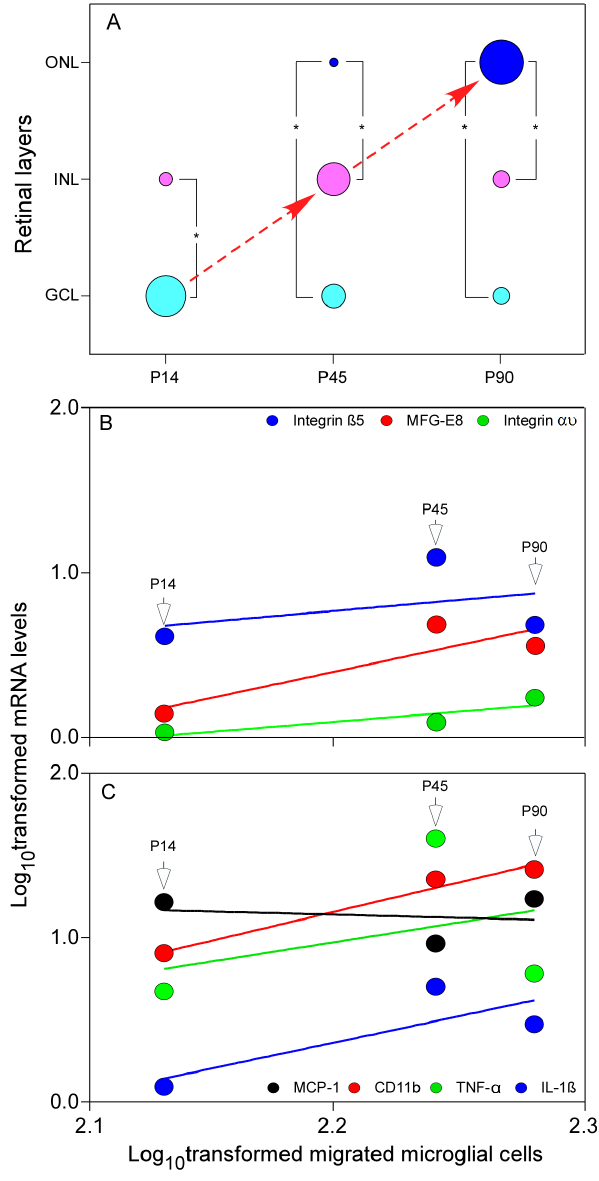
Figure 5. The distribution of migratory microglial cells and the association between mRNA levels and the number of migrated microglial cells during retinal degeneration in RCS rats. (A) The distribution of microglial cells in the retina of RCS rats from GCL to ONL during retinal degeneration from P14 to P90. (B) mRNA levels of MFG-E8 and integrin au showed more significant linear regression with the migration of microglial cells than the integrin b 5. (C) mRNA level of CD11b was significantly associated with the migration of microglial cells and IL-1 b and TNF- a showed a modestly linear regression, but the association between mRNA levels of MCP-1 and microglial cells was slightly negative, which might be owed to a dramatic reduction of apoptotic cells and a possible decrease in the phagocytic activity (or requirement) of microglial cells in the ONL.